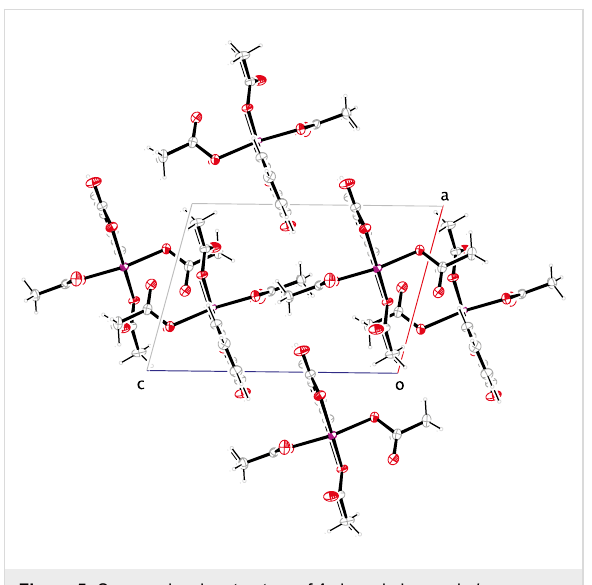
Figure 5: Supramolecular structure of 1 viewed along axis b